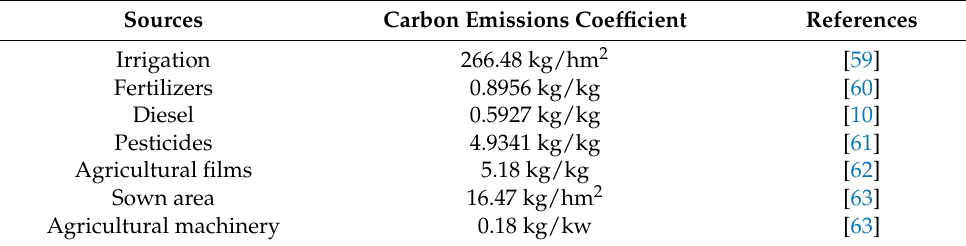
Table 4. Carbon emission coefficient of agricultural production activities.